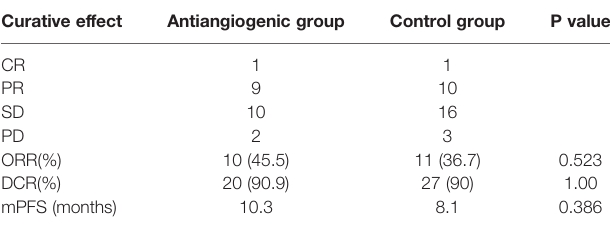
TABLE 4 | Comparison of the short-term ef fi cacy and mPFS in test group and control group. Curative